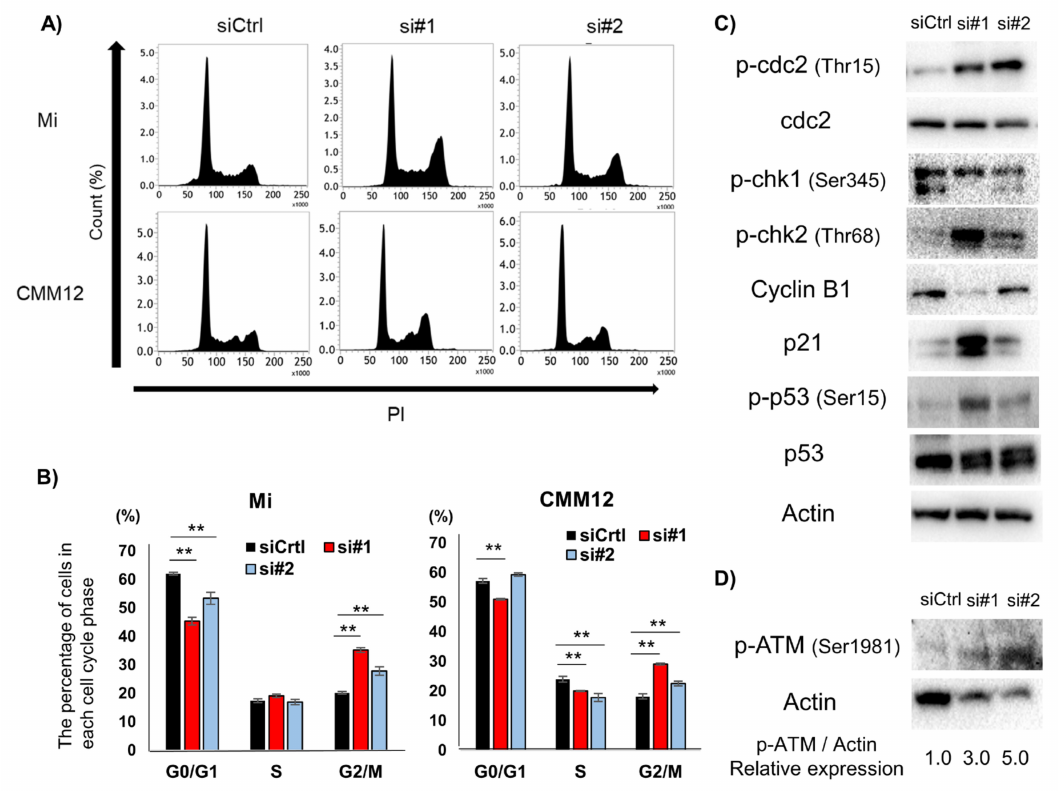
Figure 4. E ff ect of dPDPN knockdown on the cell cycle in canine MM cell lines. ( A ) Cell cycle analysis was performed in Mi and CMM12 cell lines after 48 and 72 h siRNA treatment, respectively. Representative images are shown. ( B ) The proportions of each cell cycle phase in Mi and CMM12 cell lines after siRNA treatment are summarized in graphs. This experiment was performed in triplicate. ( C ) G2 / M cell cycle-related protein expression of Mi cell line after siRNAs treatment for 48 h was evaluated by Western blot analysis. Actin was used as an internal control. ( D ) The expression of phospho-ataxia telangiectasia-mutated (p-ATM) protein in the Mi cell line after siRNA treatment for 48 h was evaluated by Western blot analysis. The values indicated under each blot are the fold protein expression relative to the control after normalization by Actin (Image Lab quantification